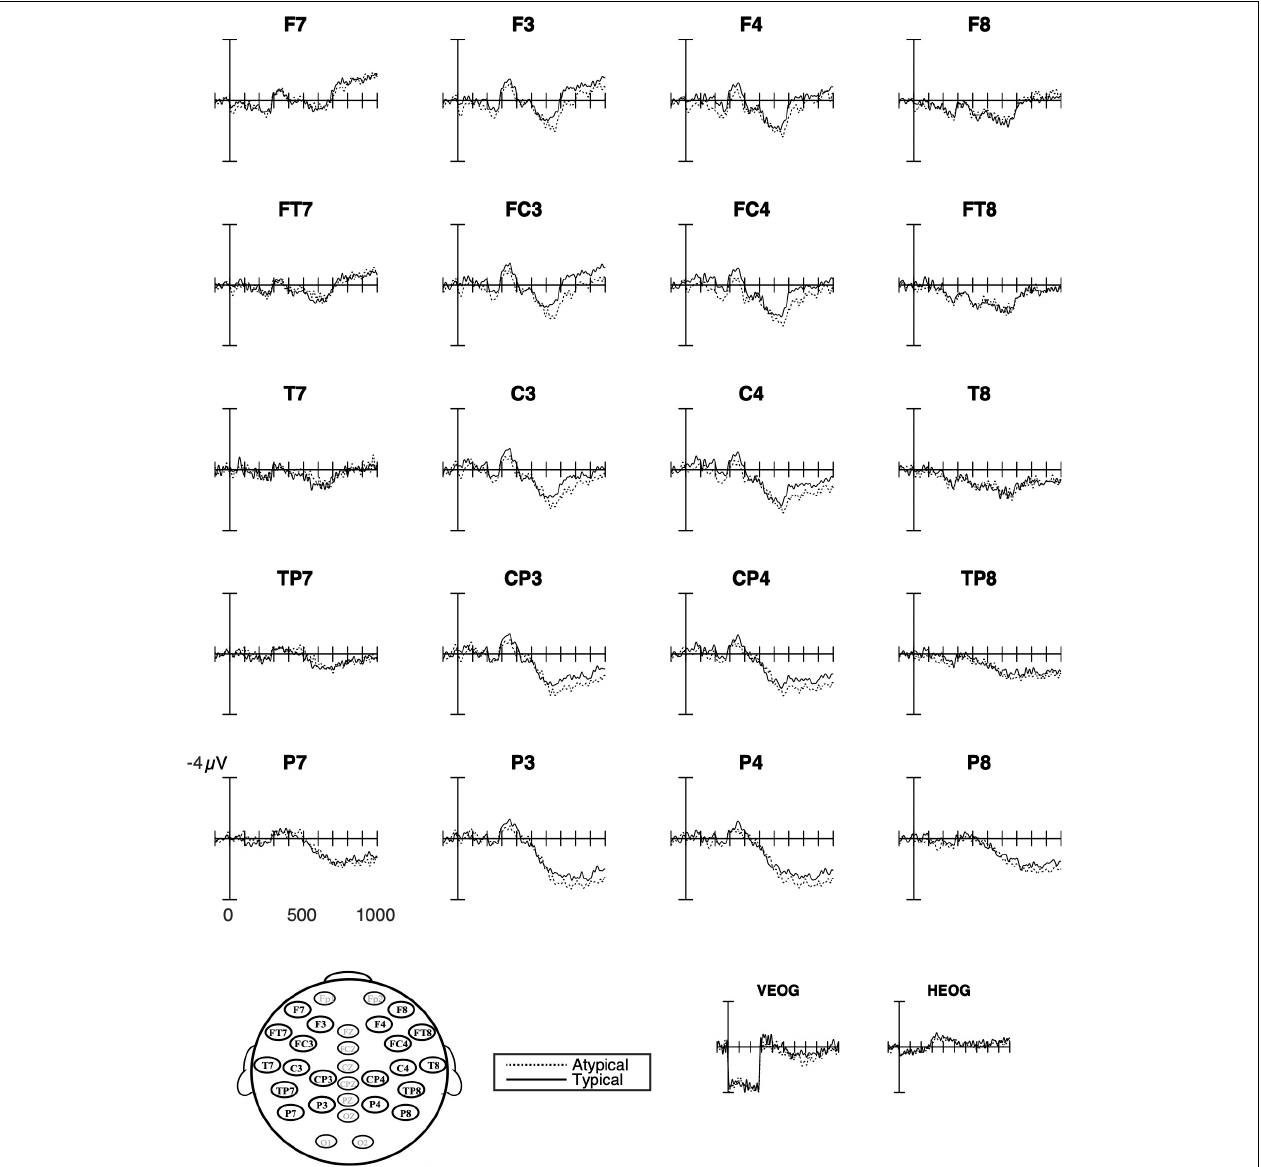
FIGURE 5 | Grand average ERPs for all groups combined at all analyzed sites. The response to the typical verb use (number of trials in the bin, n = 1,504) is shown as solid lines and the response to the atypical verb use ( n = 1,504) as dashed lines. Waveforms suggest left anterior negativity that did not differ from typicality. The P600 that was evident for both verbs posteriorly showed an effect of typicality that was strongest over medial sites. The negative is plotted upward.